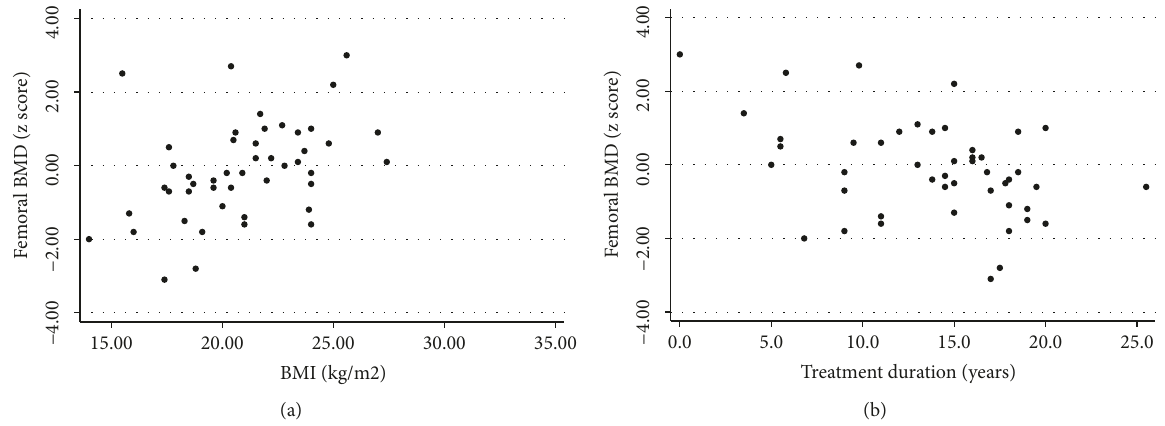
Figure 3: Scatter plots used to investigate the relationship between femoral BMD z-score and BMI (a) and treatment duration (b).